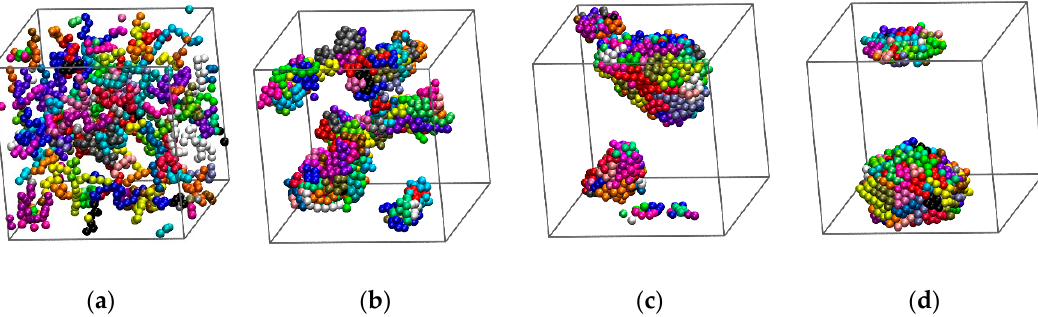
Figure 1. ( a ) Snapshot of the athermal polymer system (100-chain N = 12, φ = 0.05) serving as the initial configuration for all successive Monte Carlo simulations on chains interacting with the square-well (SW) potential. ( b – d ) System configurations for the SW chain system ( ε = 1.0 and σ 2 = 1.2) after 10 6 , 2 × 10 8 and 1.2 × 10 12 Monte Carlo moves, respectively. The number of clusters is ( a ): 73, ( b ): 8, ( c ): 3 and ( d ): 1. The formation of a stable single cluster occurs at approximately 5 × 10 9 steps. Monomers are color-coded according to their parent chain. Coordinates of sphere centers are subjected to periodic boundary conditions in all dimensions. Image created with the VMD software (version 1.9.3, Theoretical and Computational Biophysics Group, University of Illinois, Urbana, IL, USA) [72]. 3-D, interactive versions of the figure panels exist in supplement material (as well as a 3-D, interactive version of the present